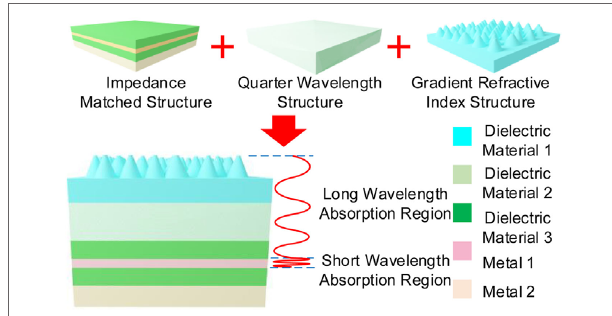
FigUre 1 | Scheme of the hierarchical structure of the tunable broadband absorber consisting of an impedance-matched structure, a quarter wavelength structure, and a gradient refractive index